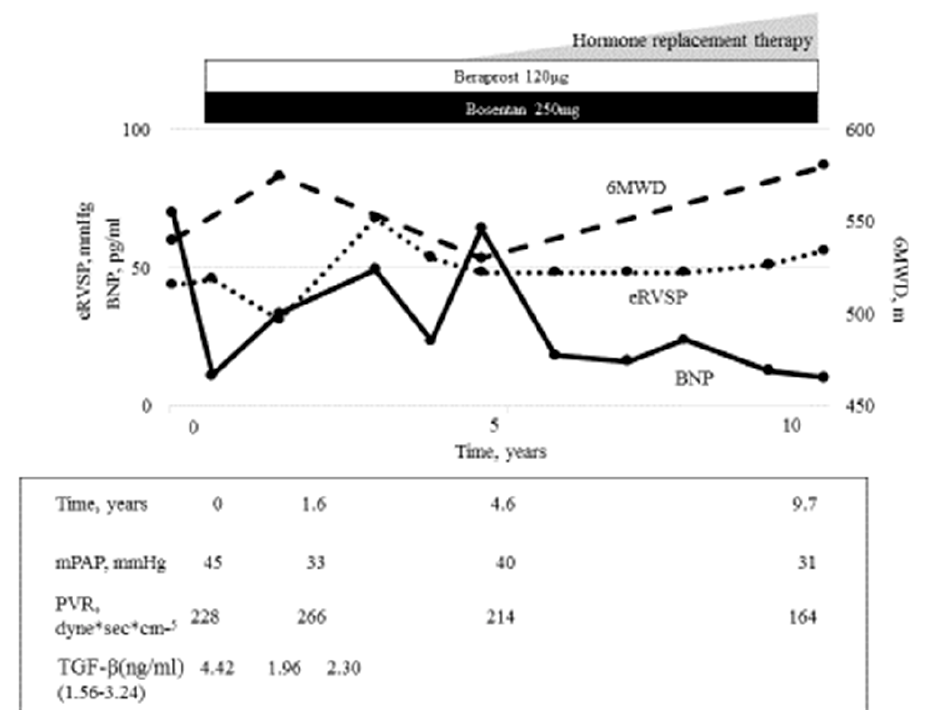
Figure 3. The clinical course most effective for a patient with PoPH. After the diagnosis of PoPH, therapy with bosentan and beraprost was started. The patient’s serum BNP level then decreased to within the normal limit. The patient’s 6MWD improved, and the PVR and mPAP decreased and were maintained at the improved level for 12 years. Serum TGF - β , which is one of most important factors for hepatic fibrosis, also decreased. RVSP, right ventricular systolic pressure; BNP, brain natriuretic peptide; PVR, pulmonary vascular resistance; mPAP, mean pulmonary arterial pressure; TGF- β , transforming Growth Factor- β ; 6MWD, 6 min walk distance.